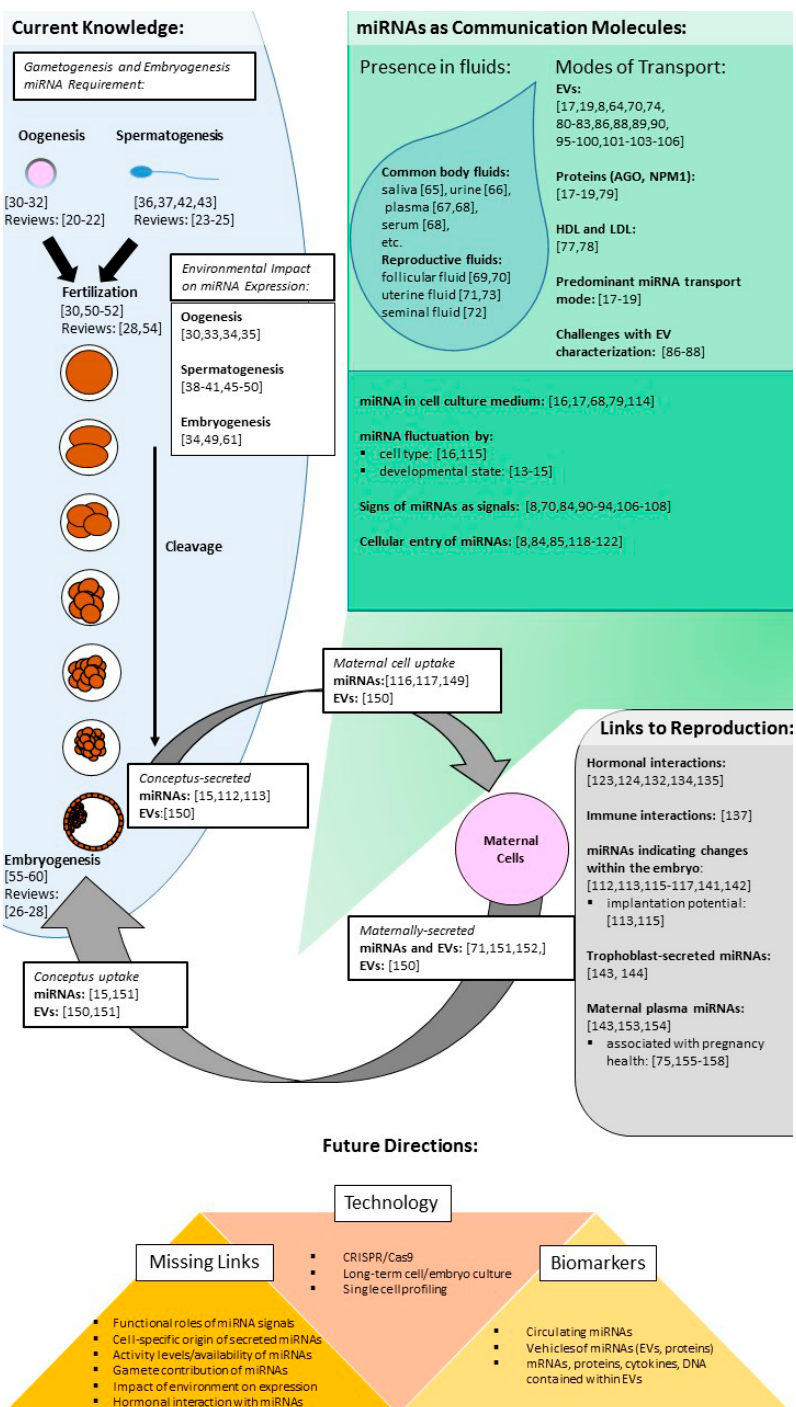
Figure 4. Summary of references on current knowledge of miRNAs in embryo development and signaling. A general schematic of references found throughout this article which outlines the links between miRNAs, embryo development, and signaling. Terms: extracellular vesicles (EVs), high-density lipoprotein (HDL), low-density lipoprotein (LDL), Argonaute (AGO) and nucleophosmin 1 (NPM1), microRNA(miRNA).